Question: Sum up the contents of this chart in one sentence.
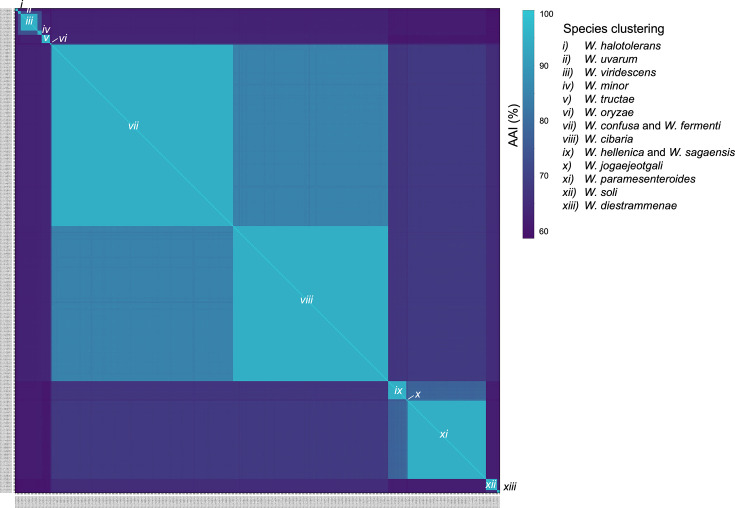
Answer: The AAI heatmap of 347 Weissella genomes. Heatmap showing pairwise AAI values among 347 Weissella genomes. Distinct clusters correspond to major species groups, with clear separation between species. Smaller blocks represent species with fewer genomes, and the lower AAI values between species are visible outside the diagonal clusters.